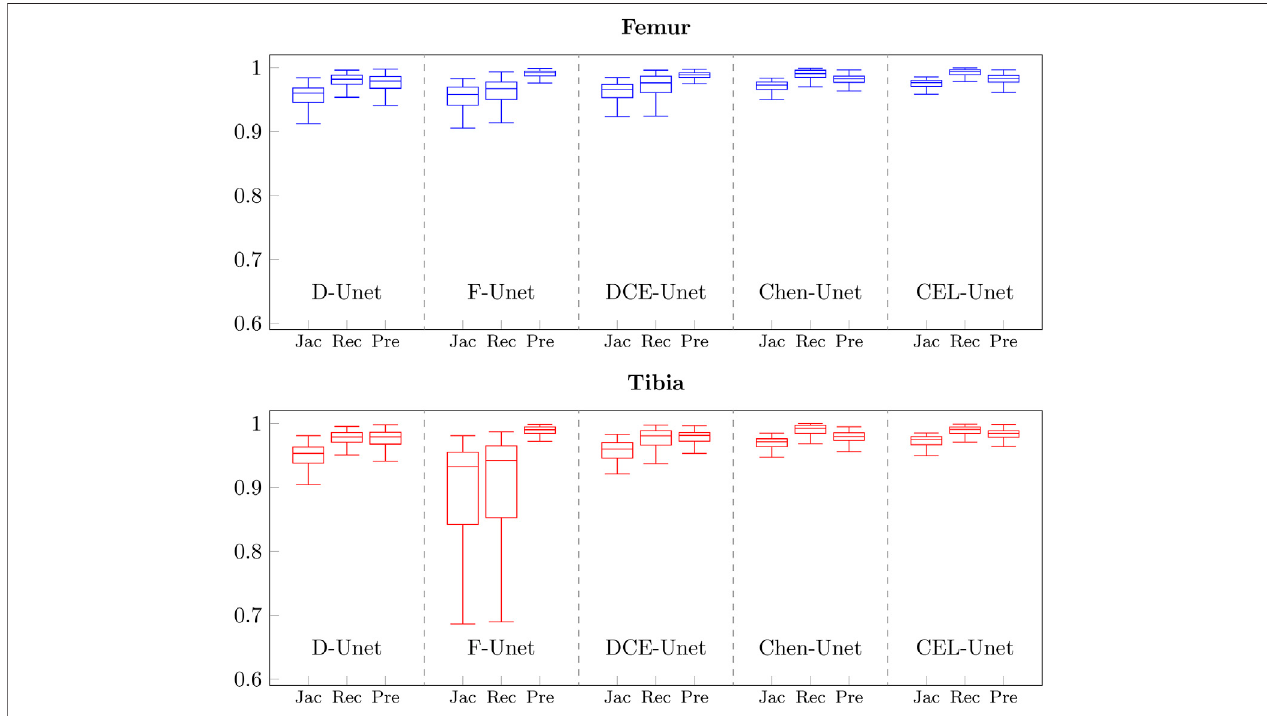
FIGURE 6 | Boxplots of Jaccard, Recall, and Precision values obtained on the test set with the fi ve different network architectures described in Table 4 for femur (blue) and tibia (red).